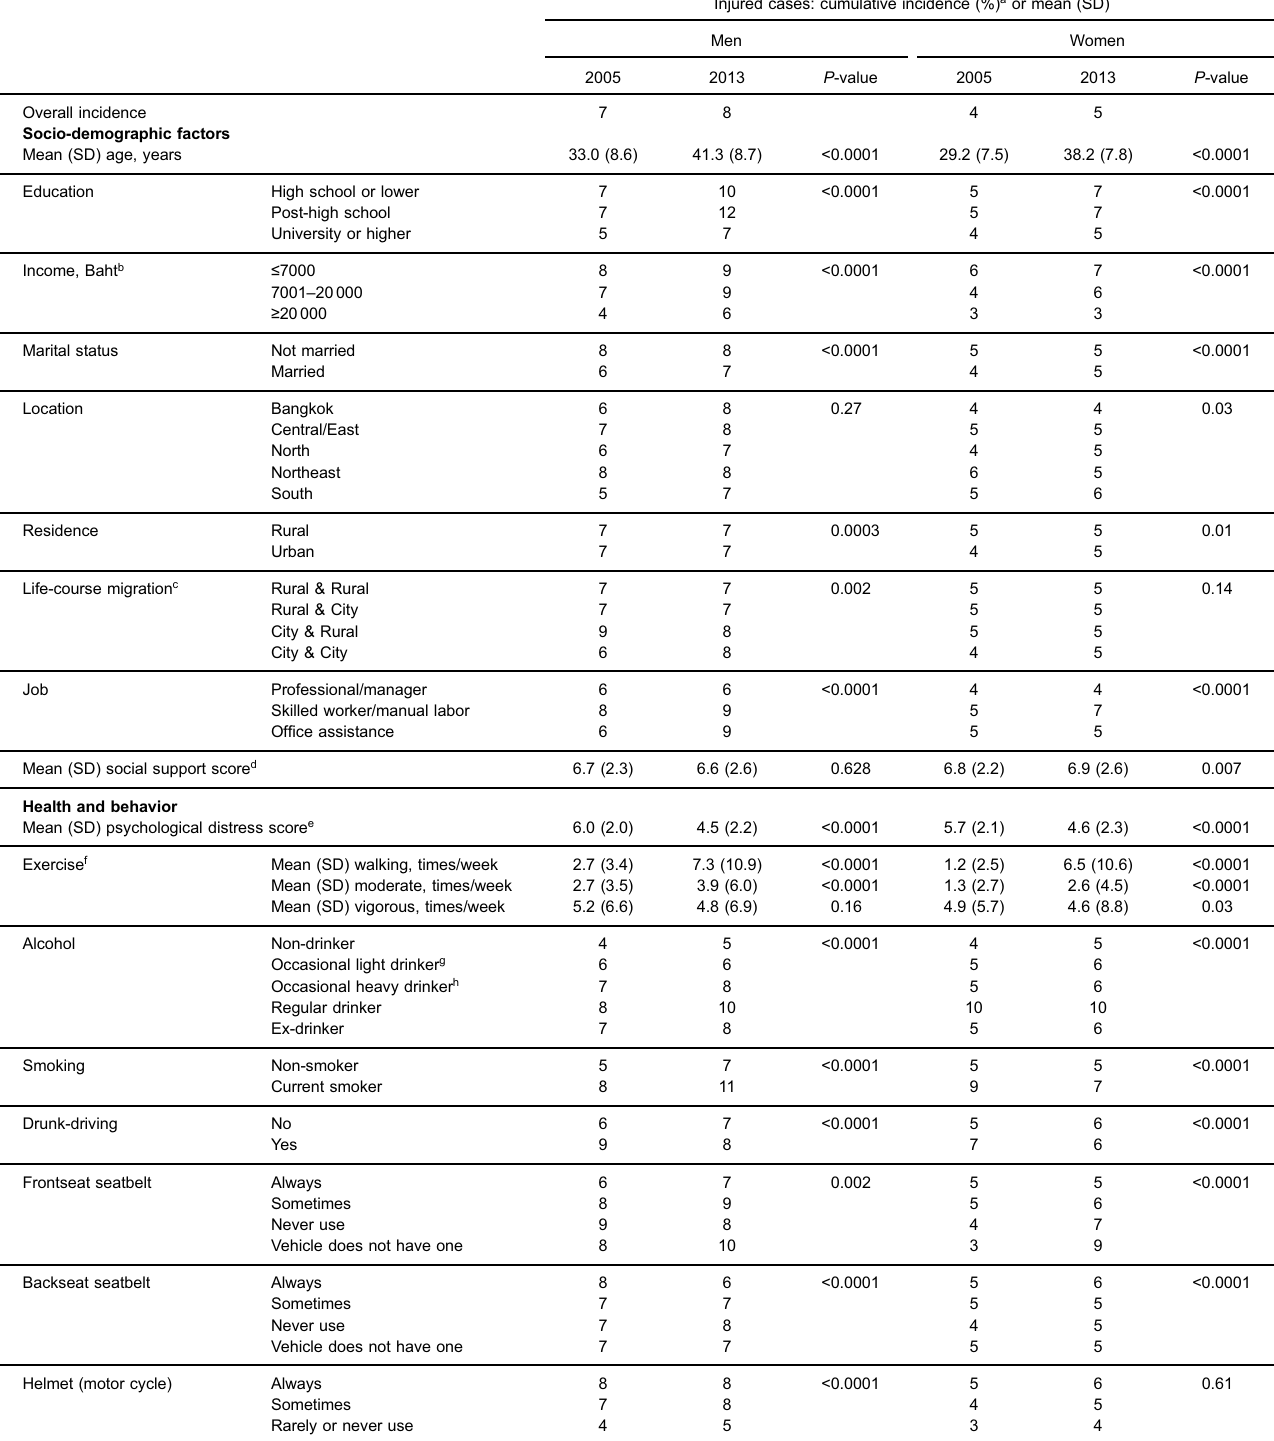
Injured cases: cumulative incidence (%) a or mean